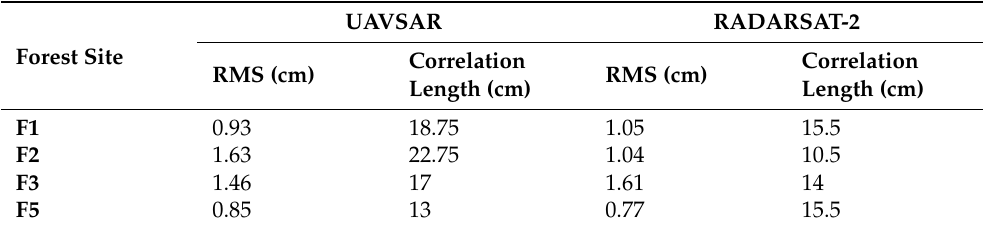
Table 2. Surface roughness measurements over SMAPVEX12 forested sites in the look direction of RADARSAT-2 and UAVSAR sensors.